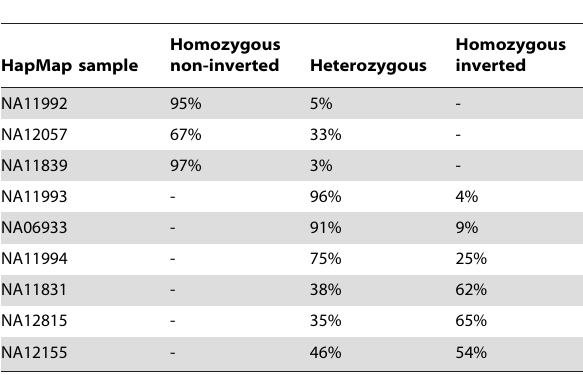
Table 3. FISH analysis in HapMap